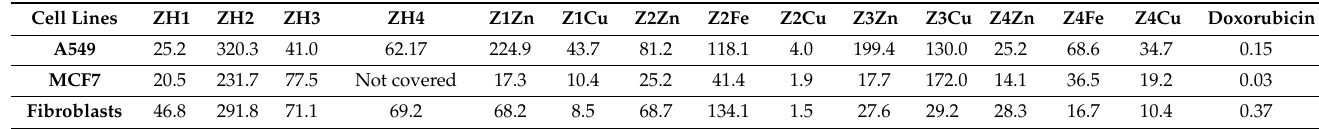
Table 3. IC 50 values ( µ g/mL) of the tested compounds after the cell viability assay (MTT), showing variable responses of the treated cell lines with different